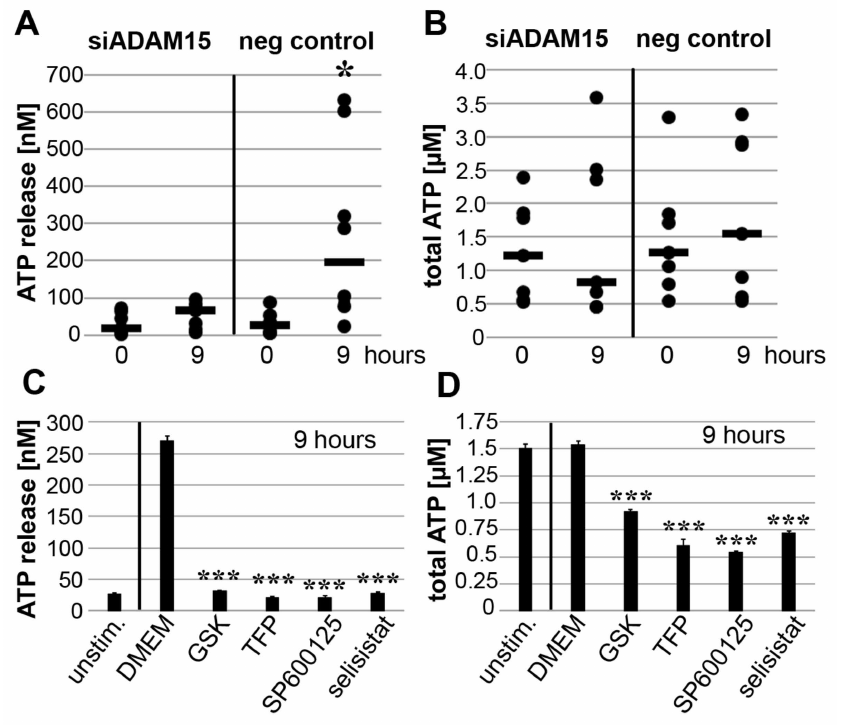
Figure 6. Strain-induced ATP release is dependent on ADAM15 and calcium signaling. ( A ) ATP release and ( B ) total ATP of SF strained for 9 h with prior downregulation of ADAM15 by siRNA and negative siRNA as control. Each dot represents the mean value of one individual donor, the horizontal bar (-) the median of 7 different donors. * p < 0.05 by Wilcoxon signed-rank test, comparing ADAM15-expressing versus non-expressing SF. ( C ) ATP release and ( D ) total ATP from SF stimulated with DMEM and inhibitors of TRPV4, CaM, JNK or SIRT1. *** p < 0.0005, by Student’s t -test, when comparing DMEM with the inhibitor. Representative results out of at least three independent experiments are